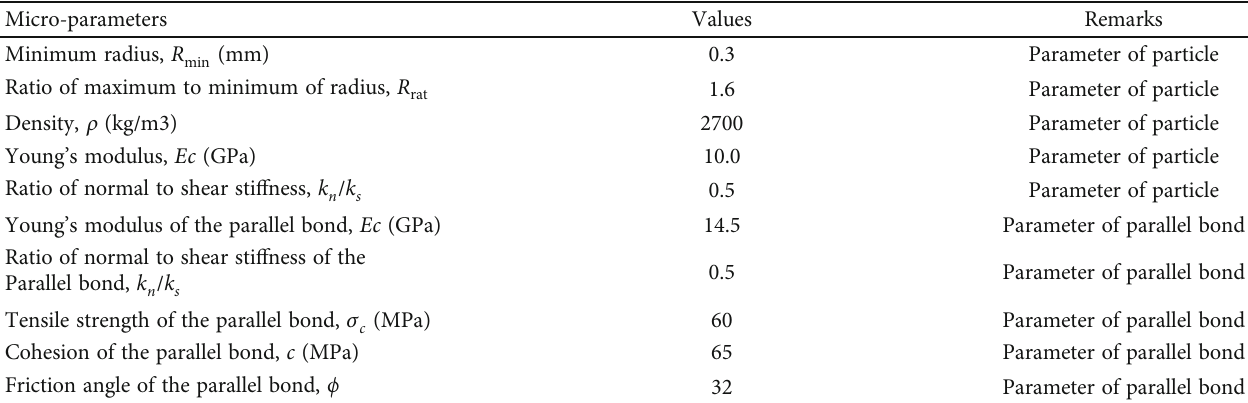
Table 1: Numerical parameters of